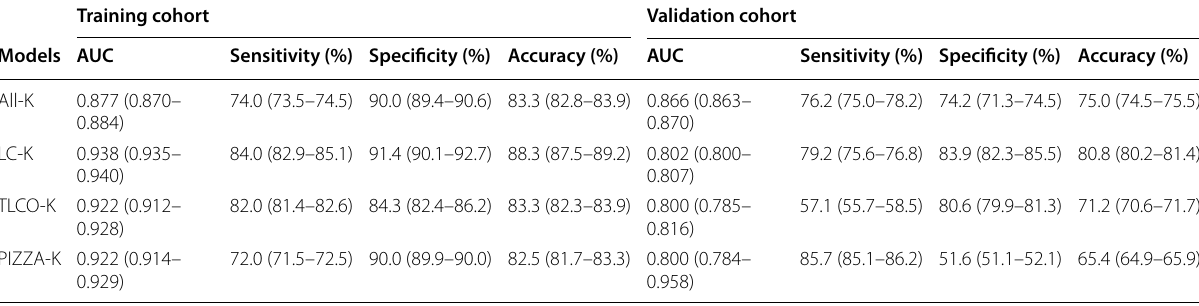
Data in parentheses are 95% confidence interval